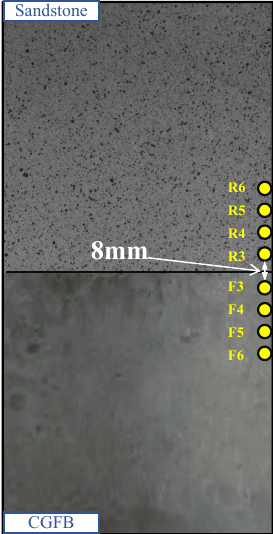
Figure 14. Schematic arrangement of monitoring points for displacement changes on the right side of the sandstone–CGFB composite samples. points R3–R6. During the period of sample loading from 0 to 40 s, measurement points